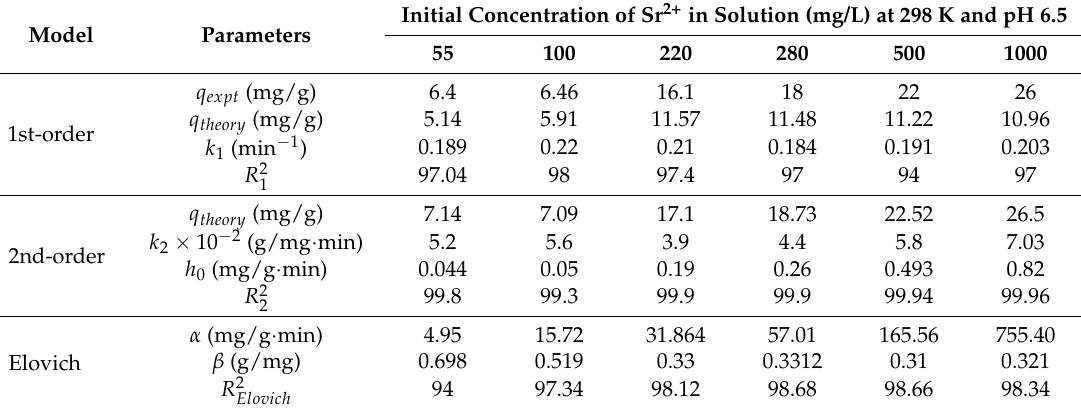
Table 6. The values for rate constants for the first-order and second-order rate constants.